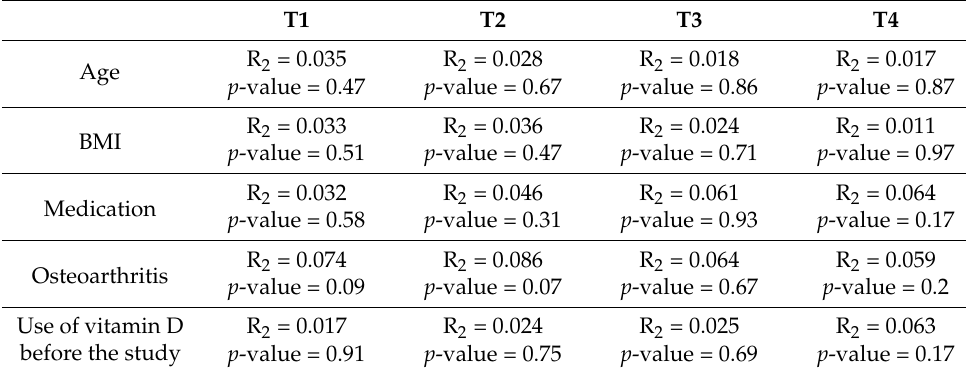
Table 2. PERMANOVA results at the different timepoints.